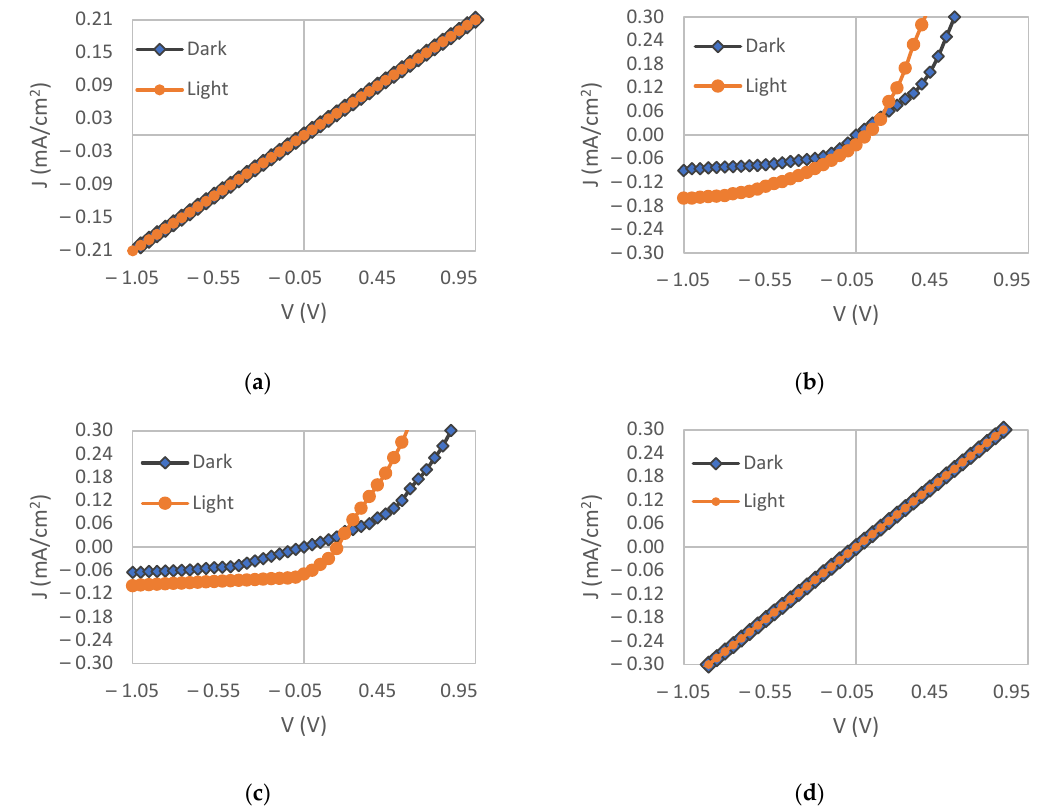
Figure 16. Current ‐ voltage curves of: ( a ) F3.10; ( b ) F3.30; ( c ) F31; ( d ) F36, in dark and illuminated